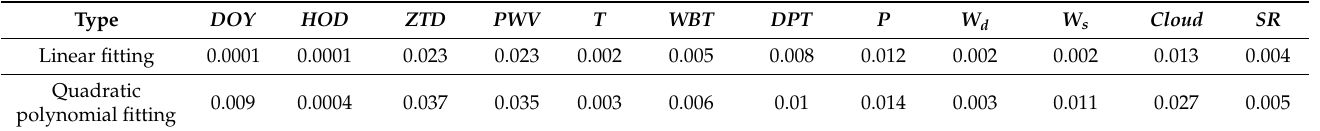
Table 5. Coefficient of determination results obtained for each of the twelve variables compared with the precipitation record using the linear and quadratic polynomial functions over the period